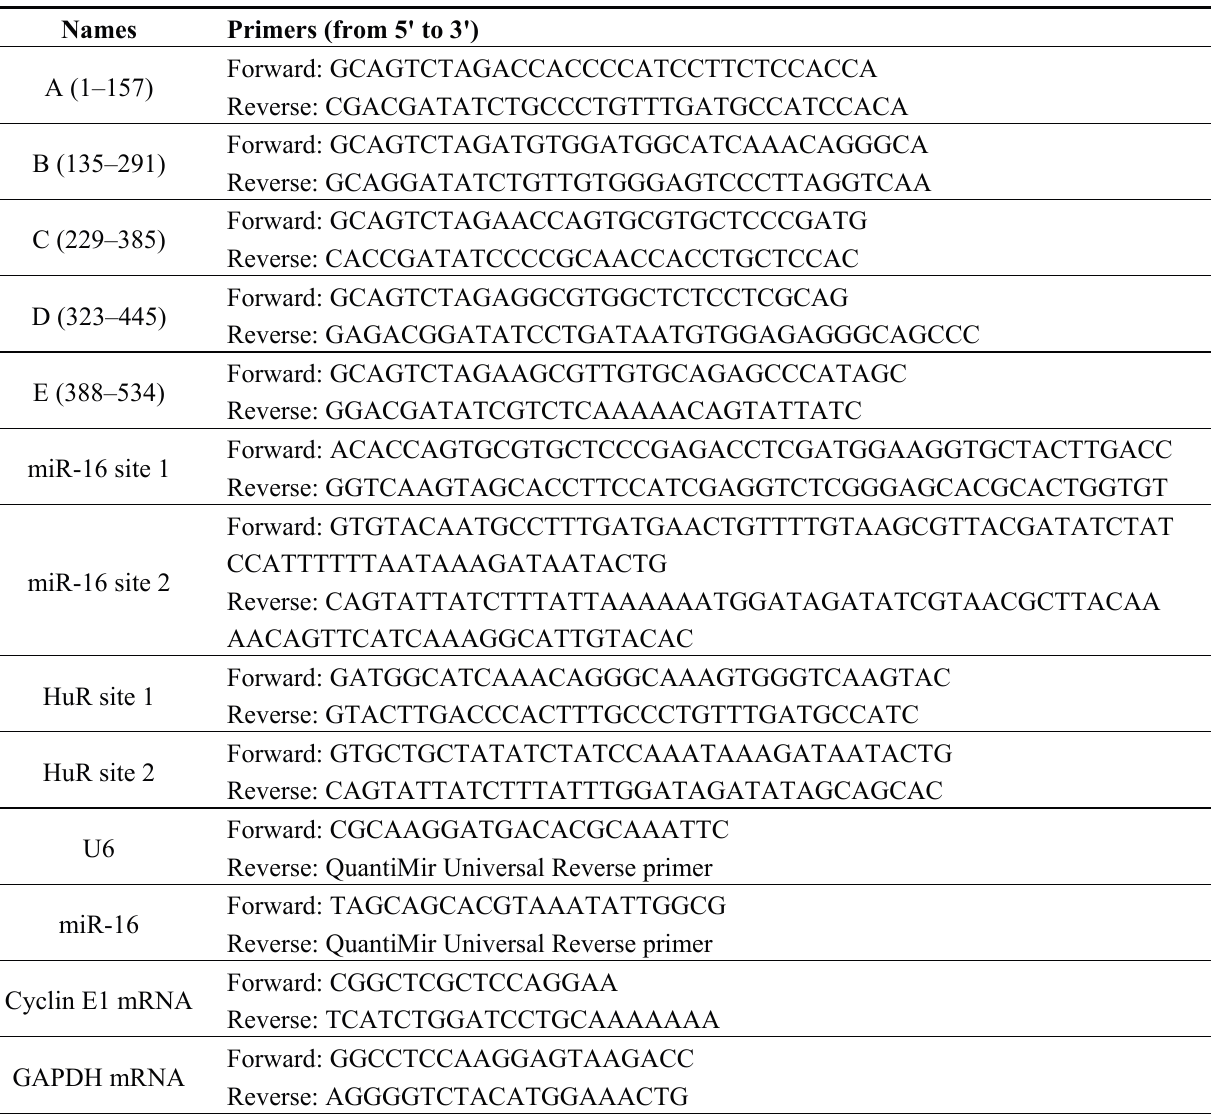
Table 1. Primers for, generating cyclin E1 3'UTR segments A–E, 3'UTR mutations, and for